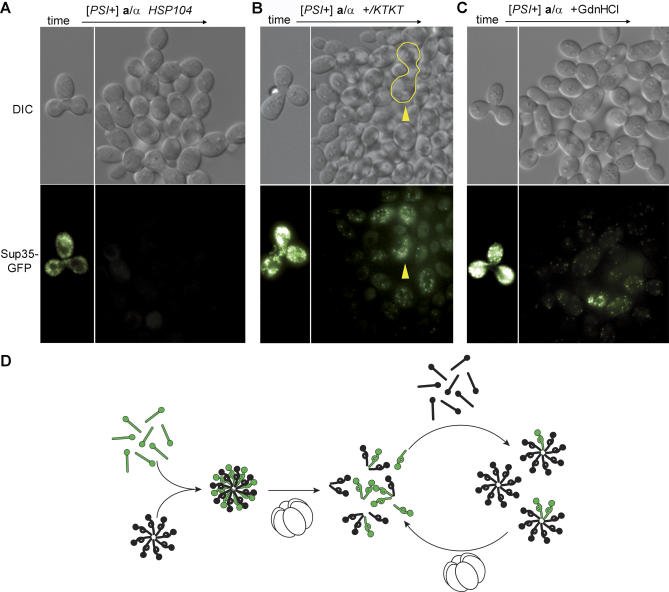
Hsp104 Inhibition Blocks Sup35-GFP[PSI+] Remodeling and Creates a Segregation Bias for Sup35-GFP Complexes
MATa [psi−] haploids expressing untagged SUP35 and SUP35-GFP from PMFA1 were mated to MATα [PSI+] haploids constitutively expressing untagged SUP35 in the presence or absence of functional Hsp104. For each cross, a zygote (left) and a microcolony derived from that zygote (right) are shown.(A) Representative images from a wild-type cross (SY360 × SY581) are shown (n = 10).(B) Shown are representative images (n = 5) from a KTKT × wild-type cross (SY876 × SY581). The originating zygote is outlined in the DIC image and marked with an arrow in the microcolony.(C) Shown are representative images (n = 6) of a wild-type cross (SY360 × SY581) in the presence of GdnHCl.(D) A model for Hsp104-dependent remodeling of prion complexes. Soluble Sup35-GFP[psi−] (green ball and stick) is remodeled to the prion form (black and green ball and loop) upon encountering Sup35[PSI+] in an Hsp104-independent process. These complexes are rapidly fragmented by Hsp104 (white hexamer) to smaller complexes, which then efficiently incorporate soluble Sup35[psi−] (black ball and stick), effectively redistributing existing Sup35-GFP[PSI+].